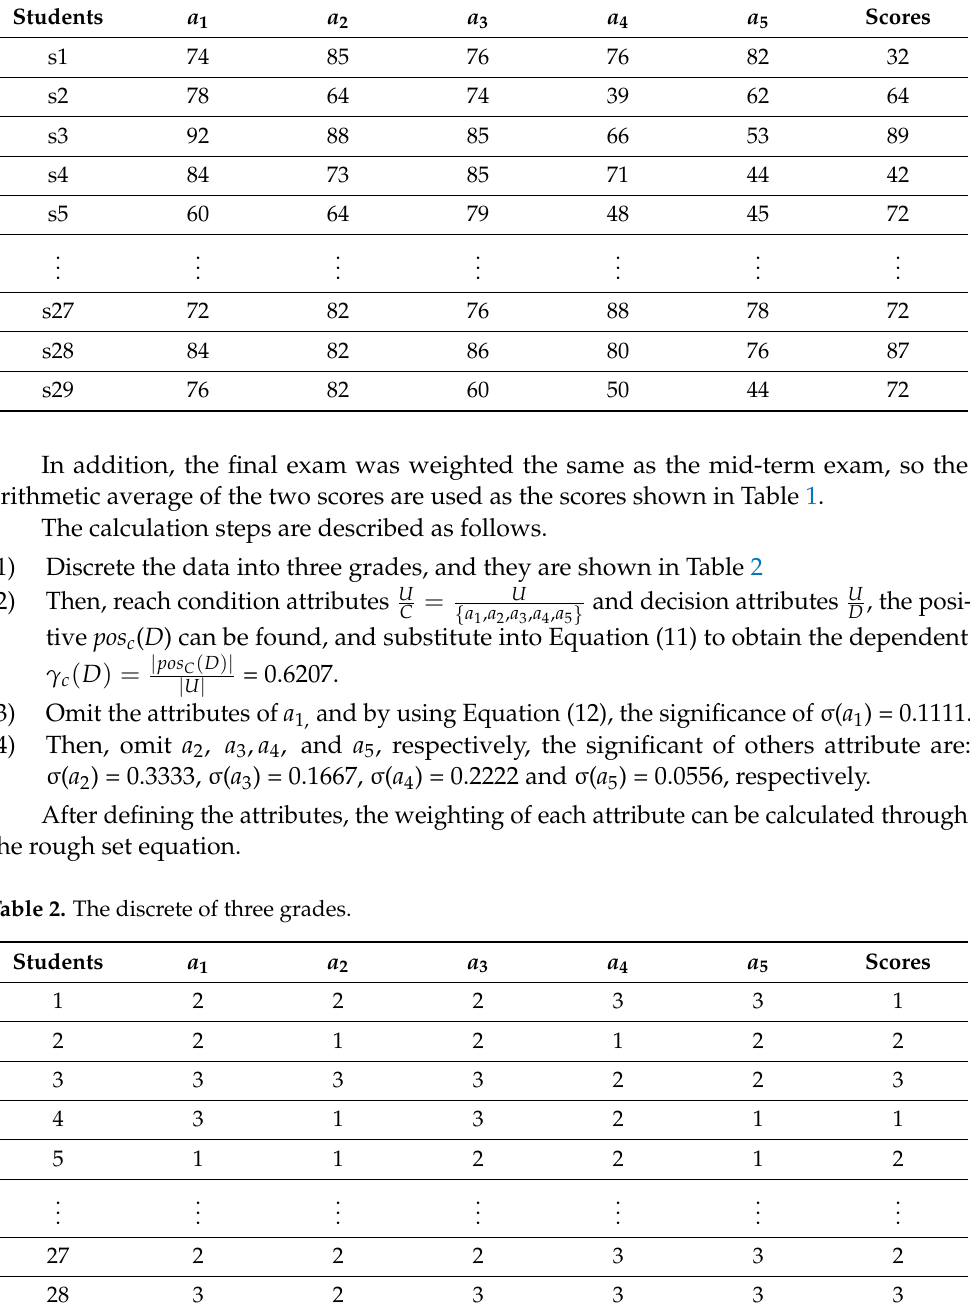
Table 1. The original data.